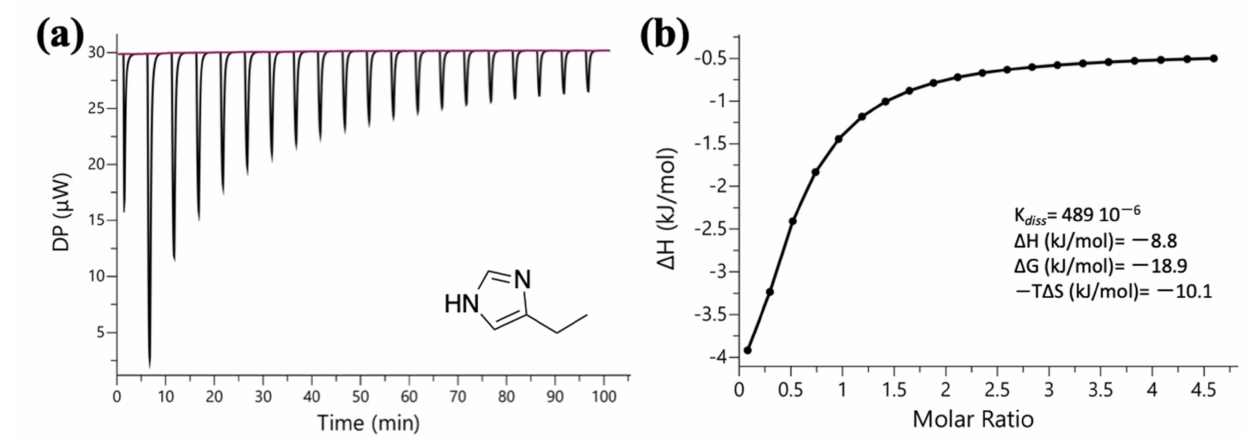
Figure 8. ( a ) Raw ITC data for the titration of 4-ethylimidazole (20 mM) into paraxanthine (1 mM), at 25 ◦ C. Both solutions were prepared in water; ( b ) Integrated heat plot (enthalpogram) of the interaction. The ITC data were plotted using the one-site binding model in order to calculate the app K diss (489 × 10 − 6